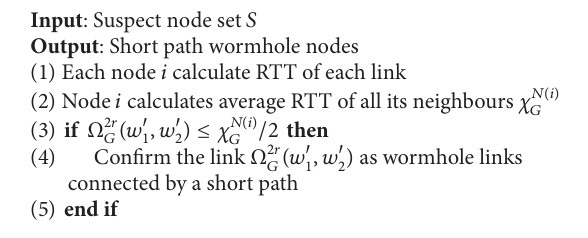
Algorithm 4: Short path wormhole detection